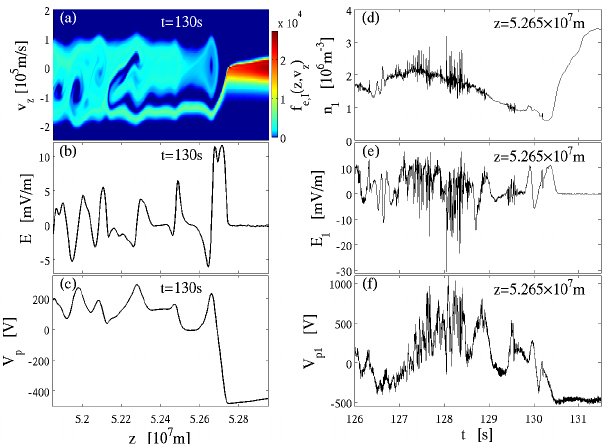
Figure 3. The double layer passing z = z 1 = 5 . 265 × 10 7 m (alti- tude 2470km) in the run with V p , I = − 400V and 4 × 10 7 m − 3 . The left column shows plasma properties at t = 130s as functions of z : (a) distribution function f (z,v z ) in units of m − 4 T − 1 s for electrons of ionospheric origin. (b) Electric field; and (c) plasma potential. The right column shows plasma properties at z = z 1 as functions of time: (d) plasma density; (e) electric field; and (f) plasma